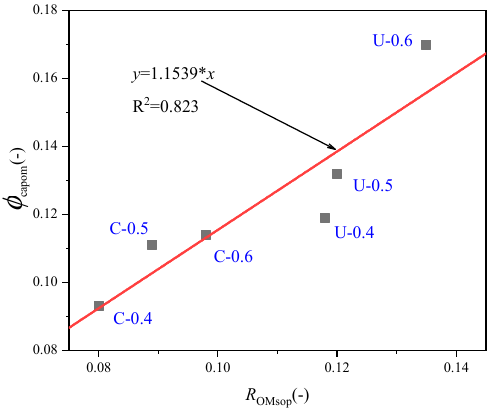
Figure 10. The relationship between water absorption and capillary porosity of old mortar.